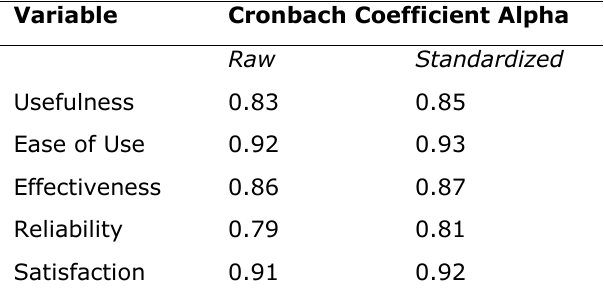
Table 5. Internal Consistency of the TUQ